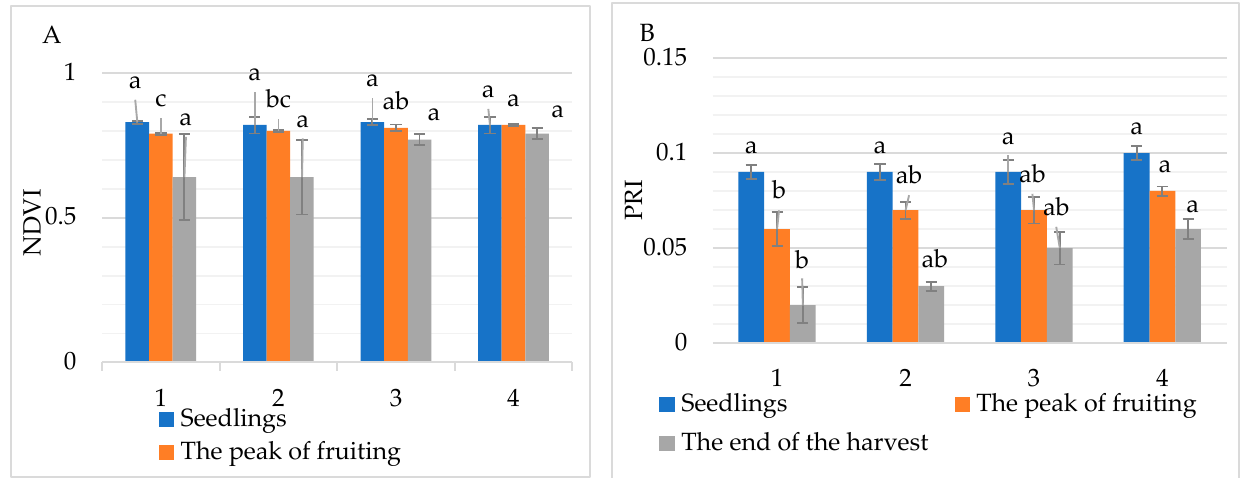
Figure 4. The effect of peat–vermicompost substrates on NDVI ( A ) and PRI ( B ) indices in the leaves of cucumbers: 1—peat; 2—peat + 10% vermicompost; 3—peat + 20% vermicompost; 4—peat + 30% vermicompost. Means with different letters are significantly different at the p < 0.05 level according to Tukey’s significant difference test. Error bars show standard deviation.